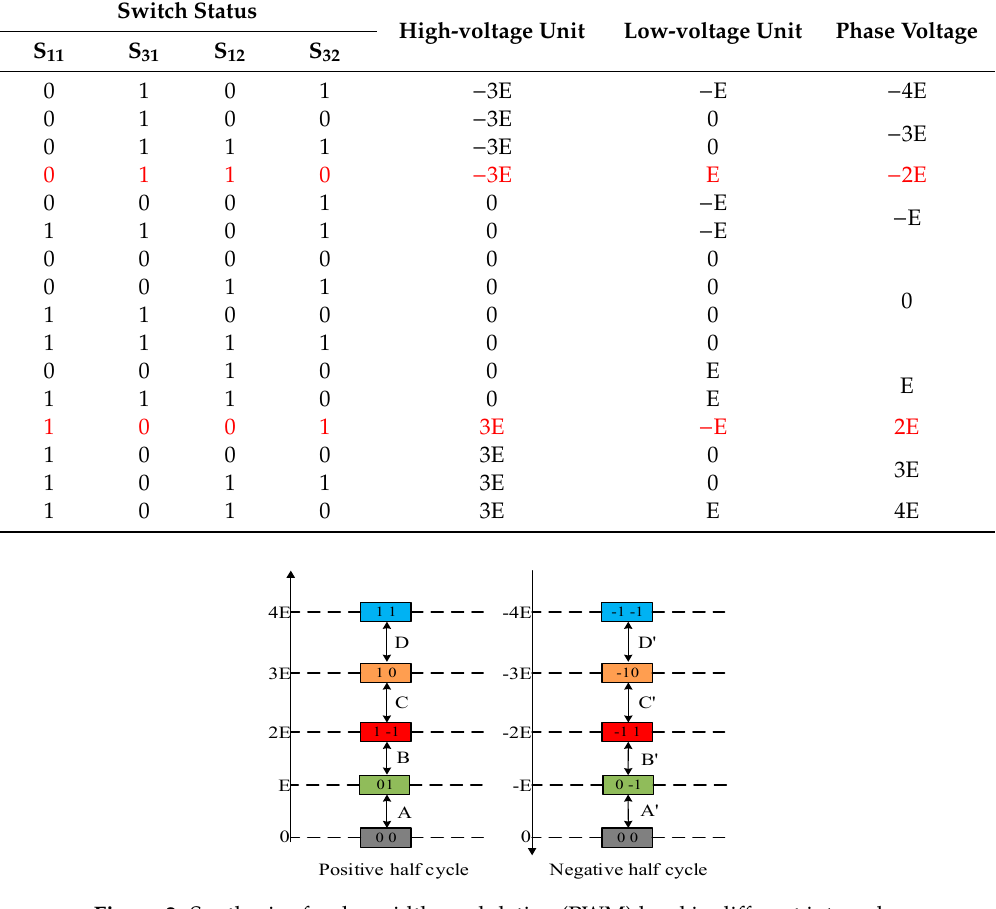
Table 1. Inverter output voltage and switching function.